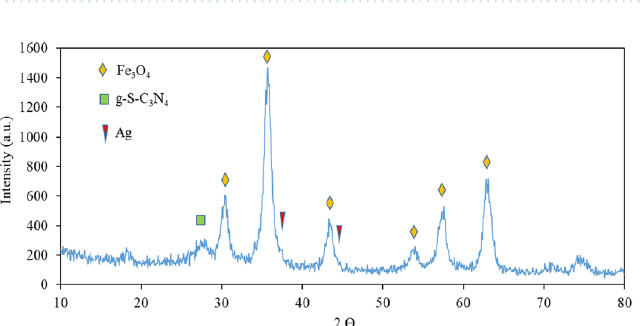
Figure 7. EDX-mapping study of Fe 3 O 4 -g-C 3 N 4 -Alg-Ag nanomaterials.